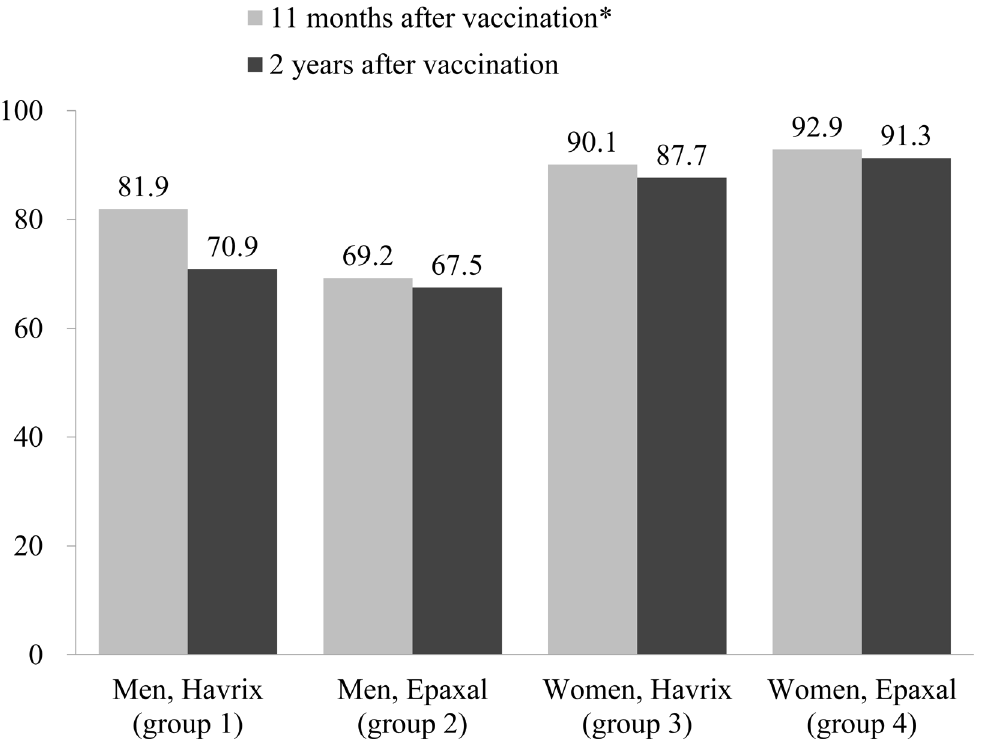
Fig 1. Change in the HAV seropositive rates from approximately 11 months to 2 years after vaccination. * Seropositive rates 11 months after a single- dose HAV vaccination were cited from our previous study